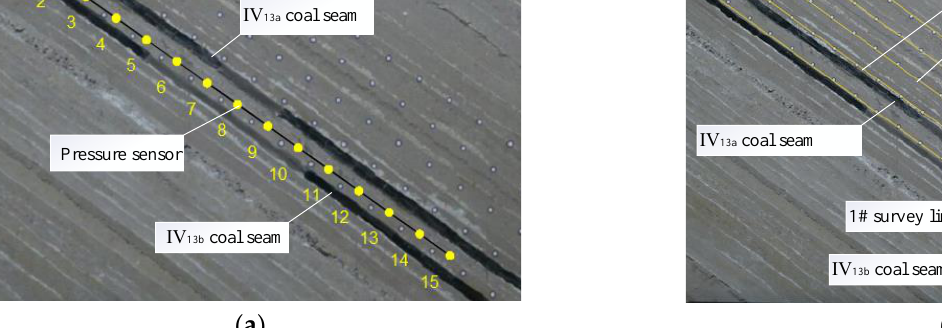
Figure 4. Layout of pressure sensor and measuring line. ( a ) pressure sensor layout; ( b ) schematic diagram of survey line.